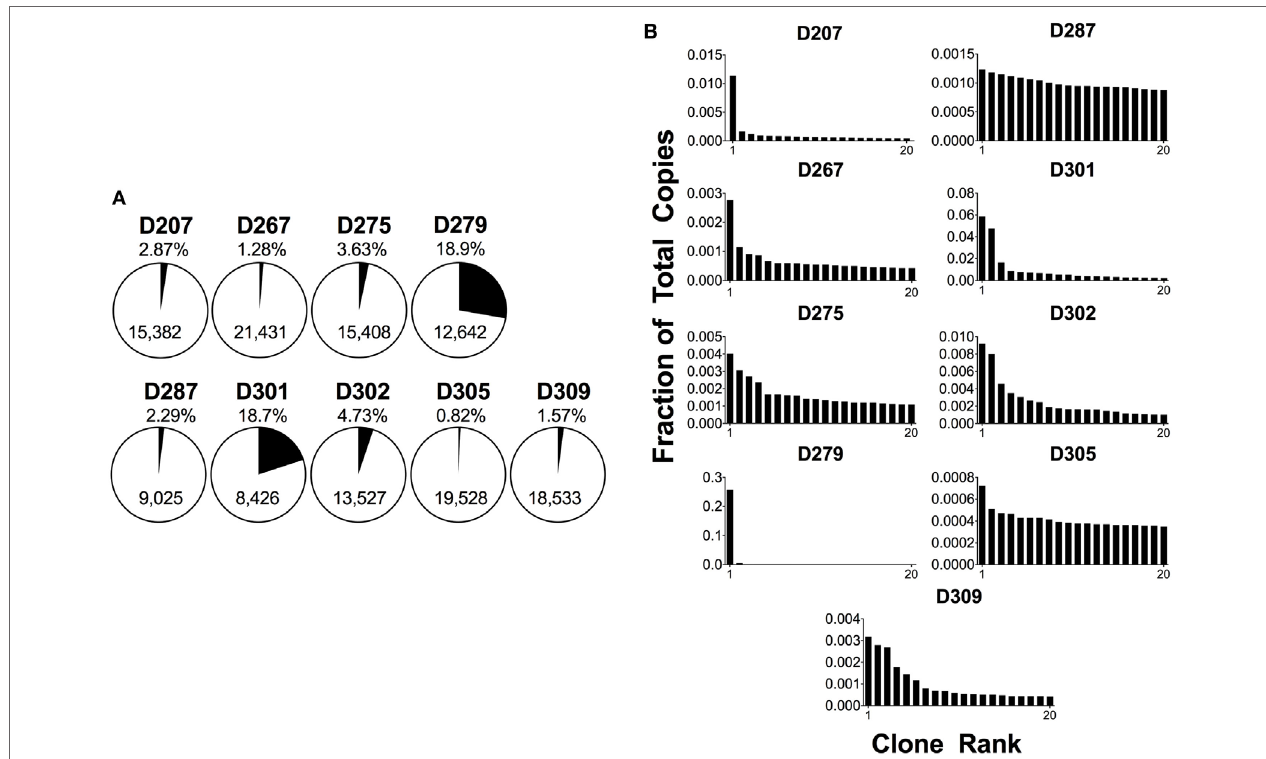
FIgUrE 4 | Analysis of 20 top-copy clones in different donors. (A) The 20 clones with the most copies in each subject are presented as a proportion of total copies in a given sample; the percentage is shown above the pie chart. The total number of clones per sample is in the body of the pie. (B) Histogram plots of the top 20 copy number rearrangements. The fraction of total copies for each rearrangement is plotted vs. the clone